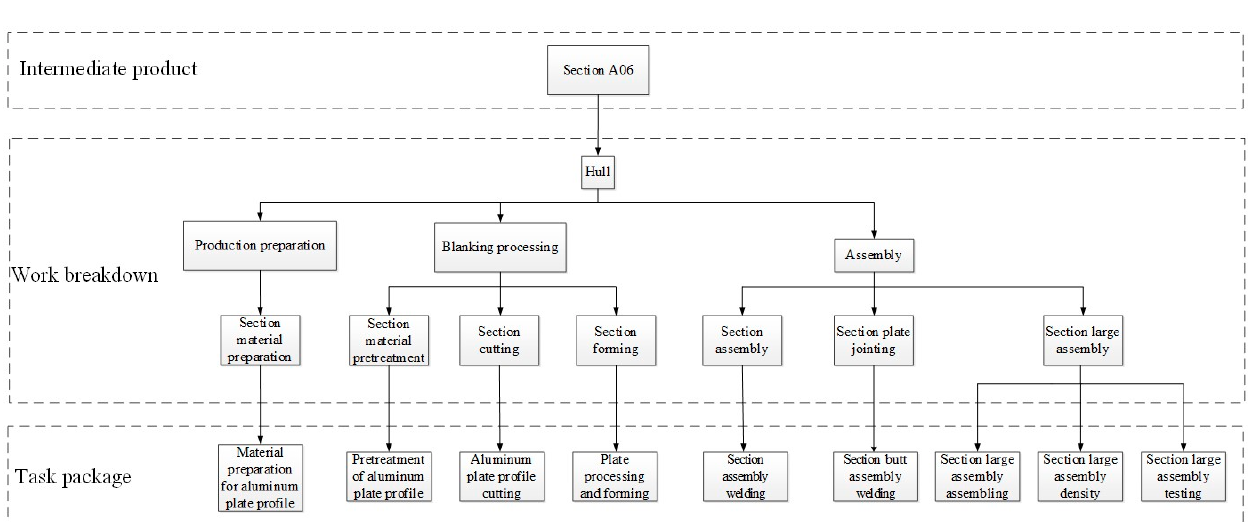
Figure 4. Schematic diagram of patrol boat section subdivision.